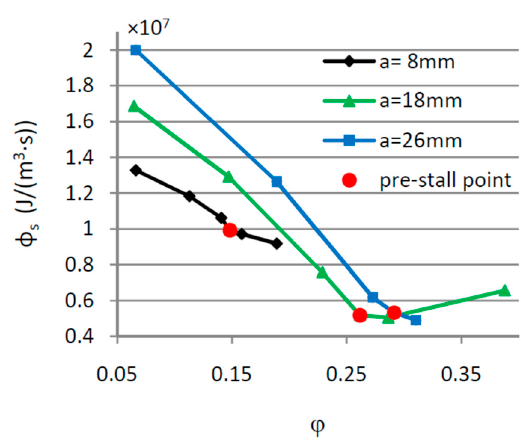
Figure 8. Curves of dissipation φ S in the Zone at measurement conditions.